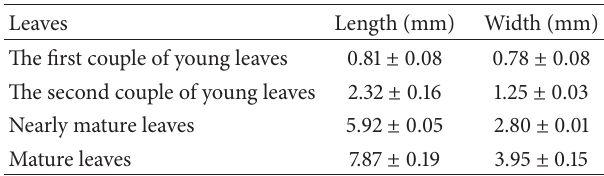
Table 1: The size of leaves at different developing stages of T. quinquecostatus